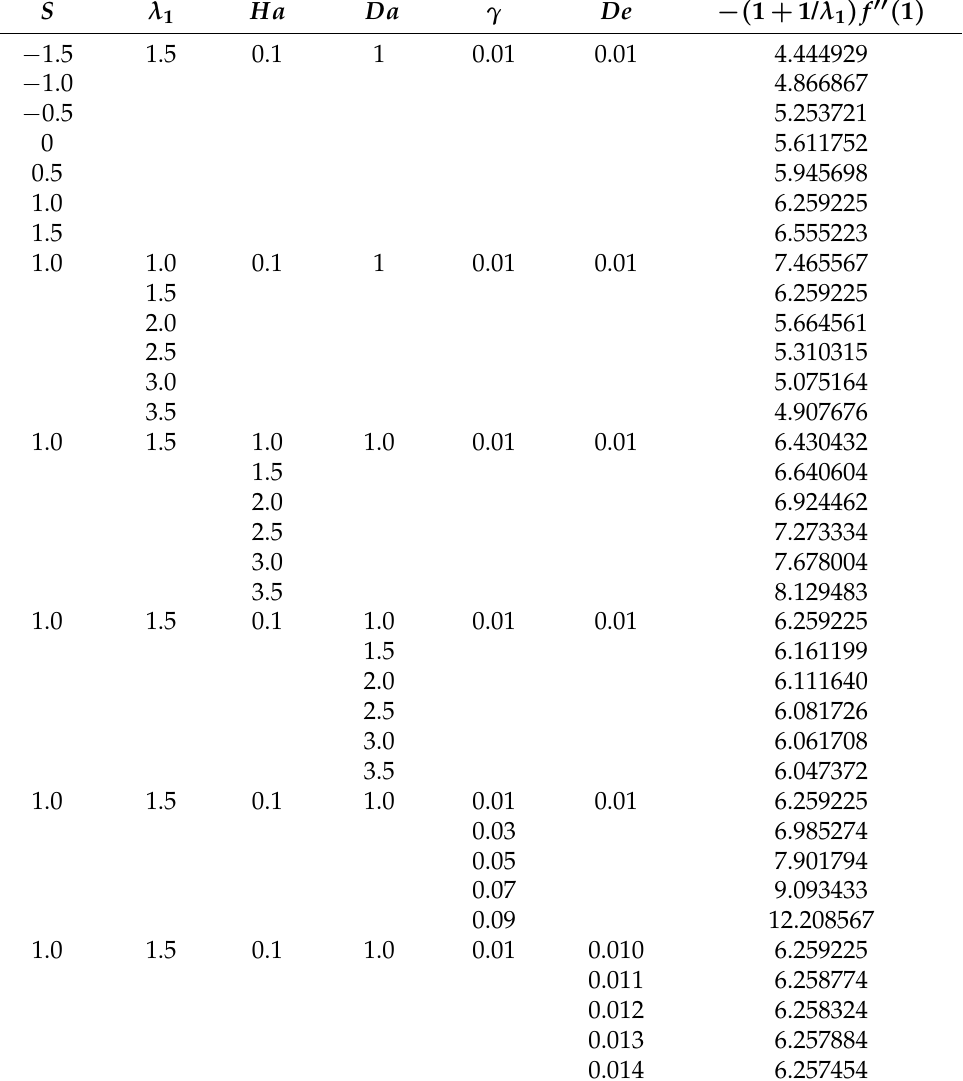
Table 5. Numerical outputs of − ( 1 + 1/ λ 1 ) f (cid:48)(cid:48) ( 1 ) for S , λ 1 , Ha , Da , De and γ when